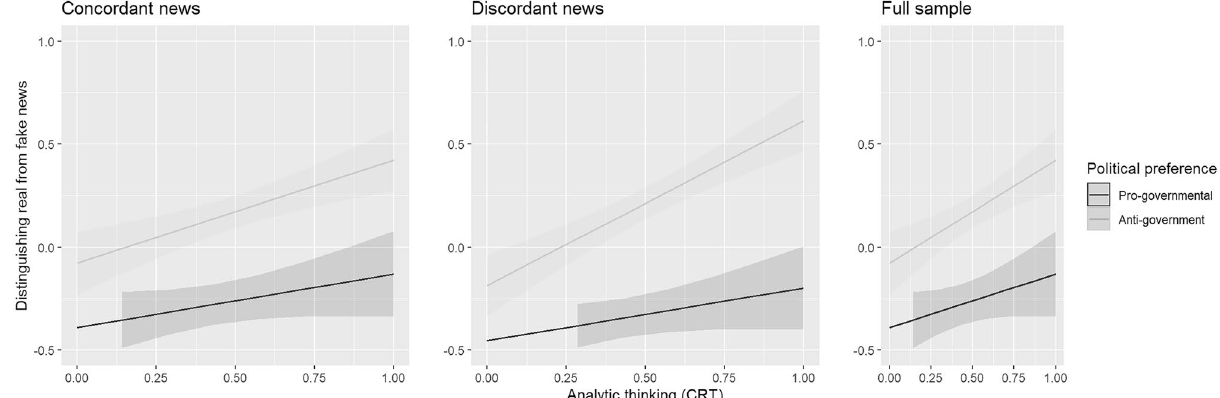
Figure 3. The interaction between analytic thinking and partisanship on media truth discernment for concordant news, discordant news, and for the full sample (including all types of news). The result suggests that anti-government voters can benefit more from analytic thinking in terms of distinguishing fake from real news compared to pro-government voters. Note. Analytic thinking (x-axis): 0 = minimal score of analytic thinking; 1 = maximal score of analytic thinking. Distinguishing real from fake news = Media truth discernment. On the y-axis, low values indicate the correctness of fake news with incorrect ratings of real news, while high values indicate the perceived inaccuracy of fake news with correct ratings of real news. Negative values mean that people found fake news more accurate than real news. Positive values indicate that real news correctness ratings are higher than fake news correctness